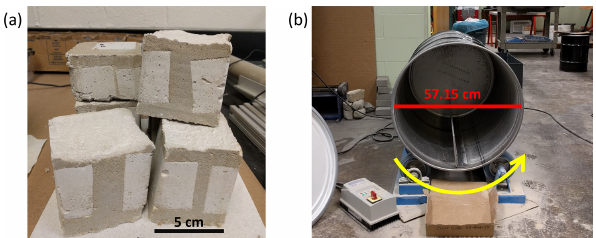
Figure 3. Experimental materials and setup. (a) Concrete parti- cles prior to breakdown in the drum. (b) The 208.20L (55gal) carbon steel drum used for collision experiments. The drum is 57.15cm in diameter, 83.31cm long, and rotates counterclockwise at 20rotationsmin − 1